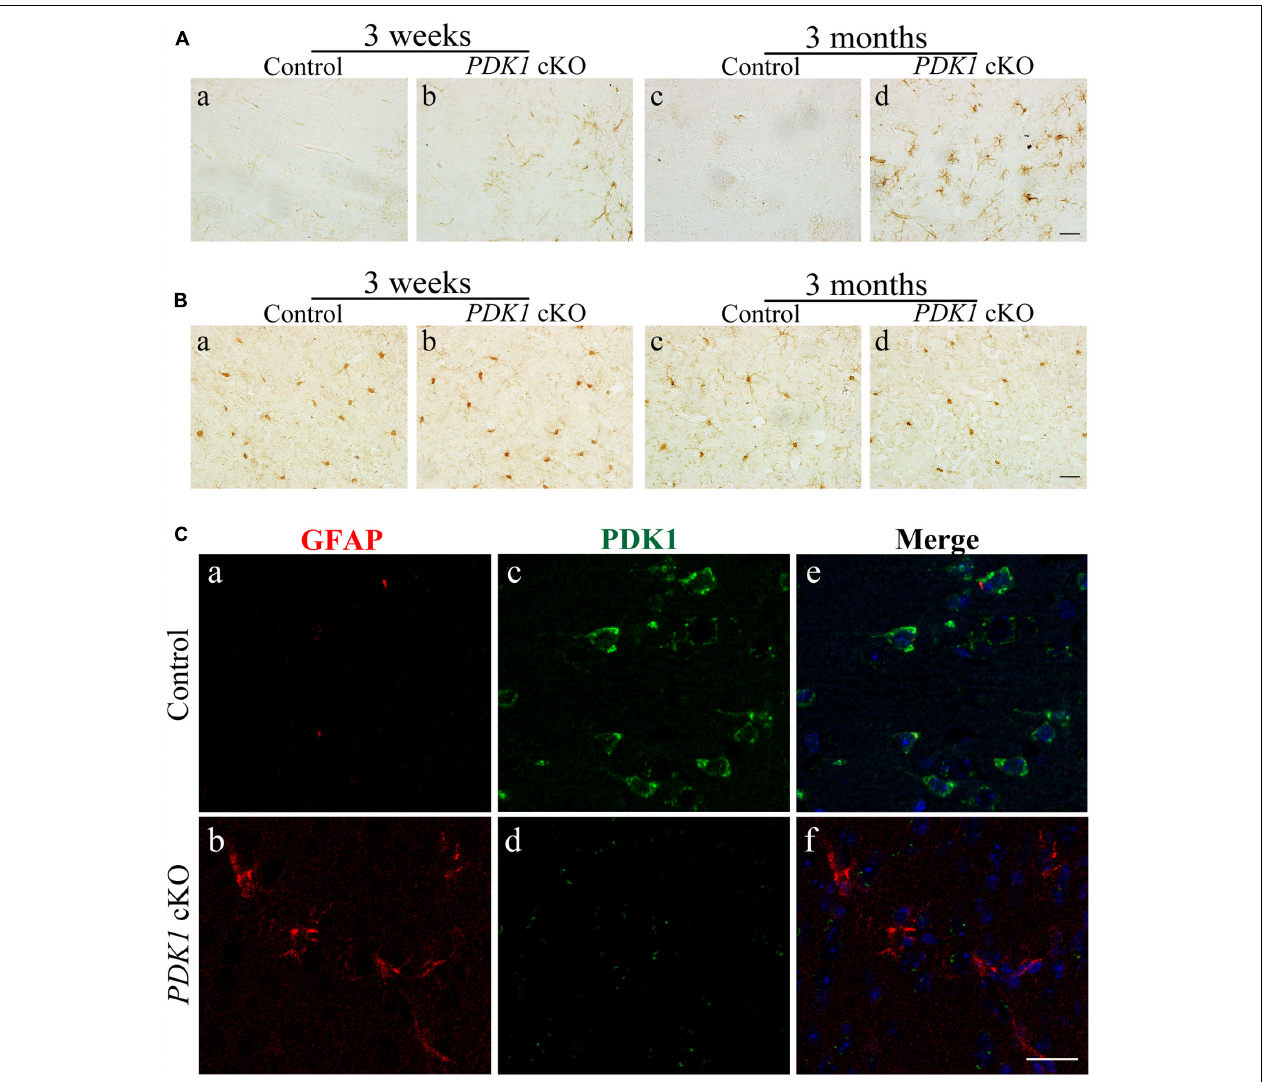
FIGURE 4 | Astroglial activation in PDK1 cKO mice. (A) IHC for GFAP. There was increased number of GFAP+ cells in the cortex of PDK1 cKO mice at 3 weeks or 3 months. Scale bar = 20 µ m. (B) IHC for Iba1. There was no significant change on the total number of Iba1+ cells in the cortex of PDK1 cKO mice at 3 weeks or 3 months. Scale bar = 20 µ m. (C) Double-immunostaining for GFAP/PDK1. Abundant PDK1+ neurons but few GFAP+ cells were seen in the cortex of control mice (a,c,e). GFAP+ cells were PDK1 negative in PDK1 cKO mice (b,d,f). Scale bar = 25 µ